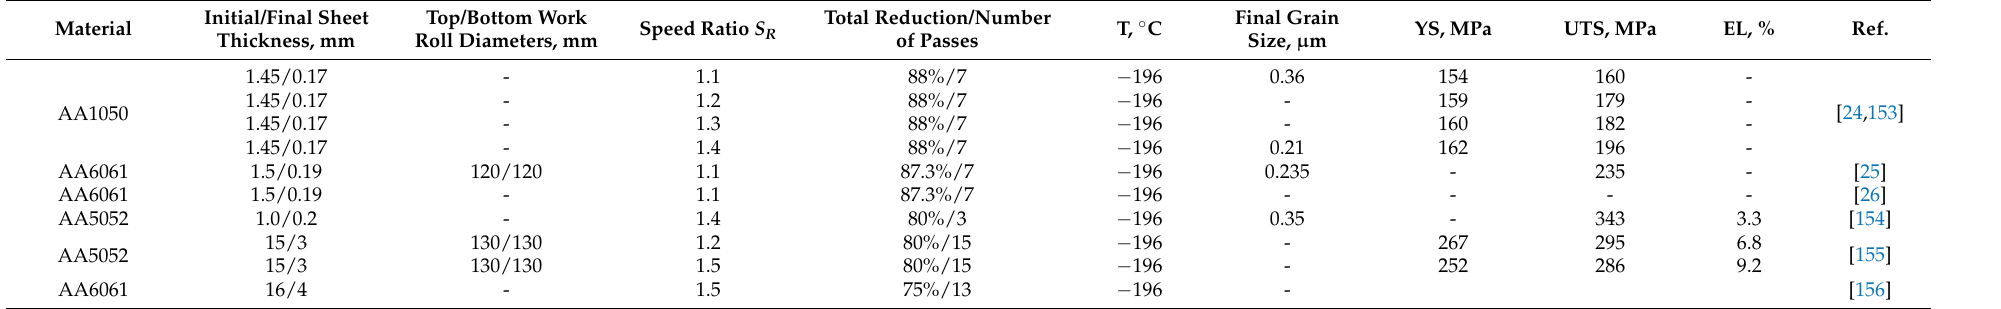
Table 8. Experimental data related to asymmetric cryorolling of Al